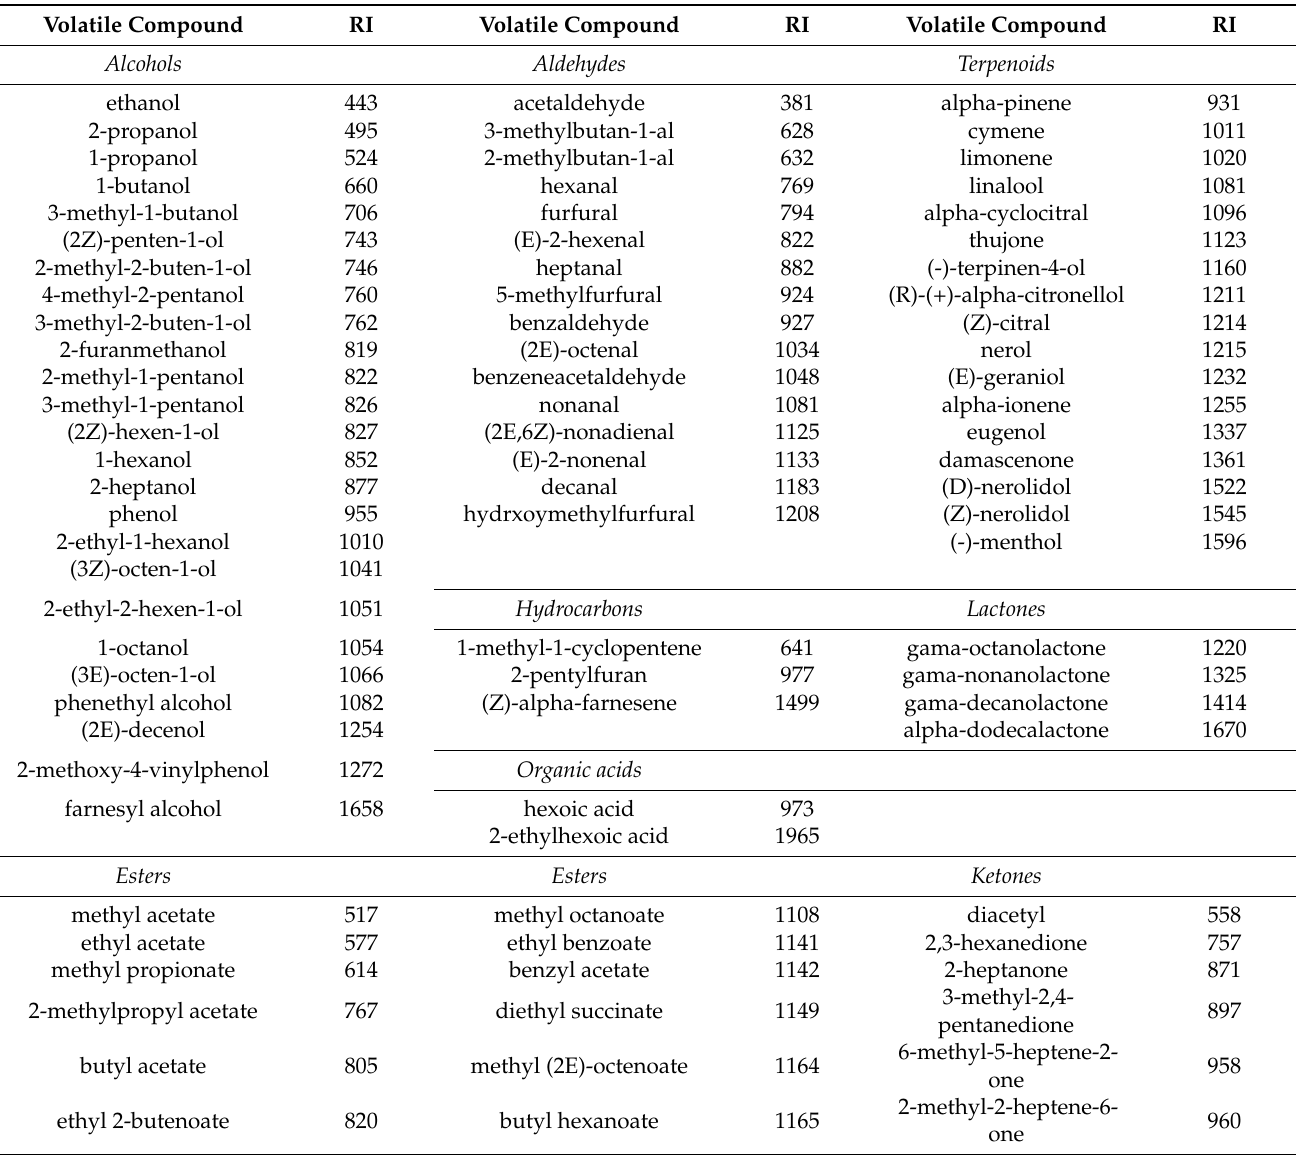
Table 1. Determined volatile compounds in ‘Conference’ and ‘Yali’ pear